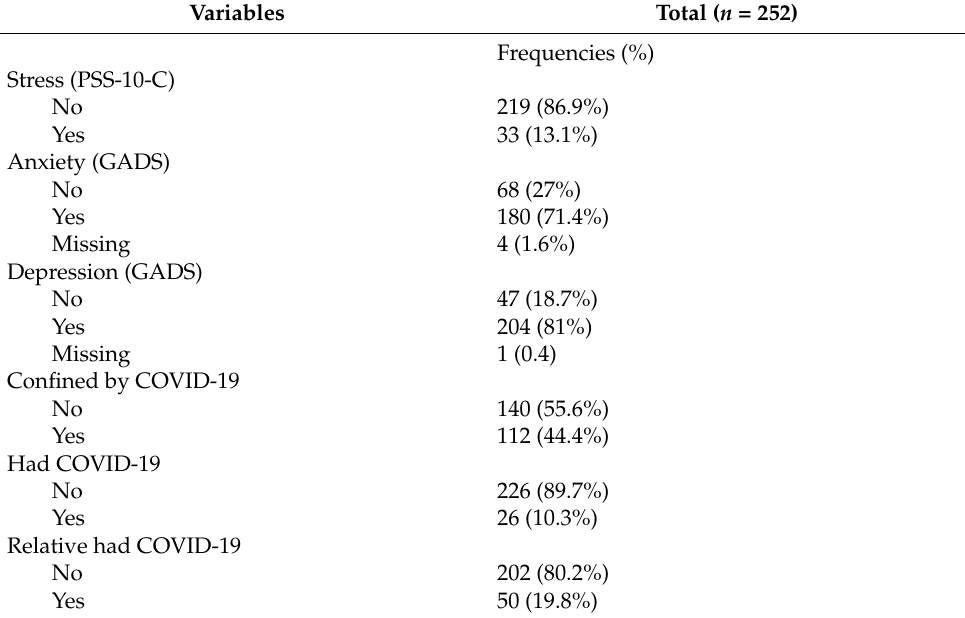
Table 2. Well-being/health